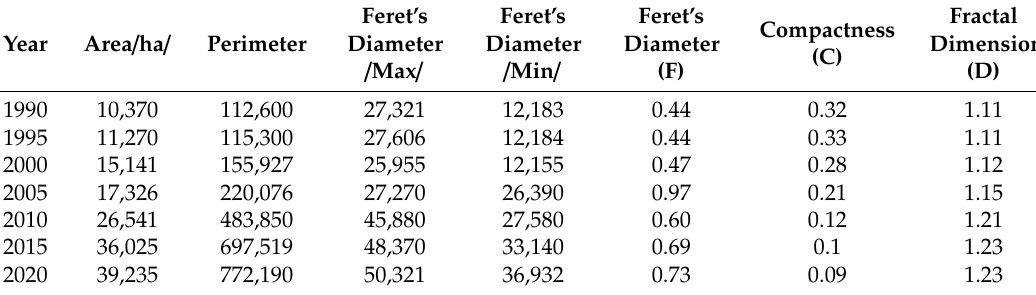
Table 2. Changes in the land-use form of Ulaanbaatar city